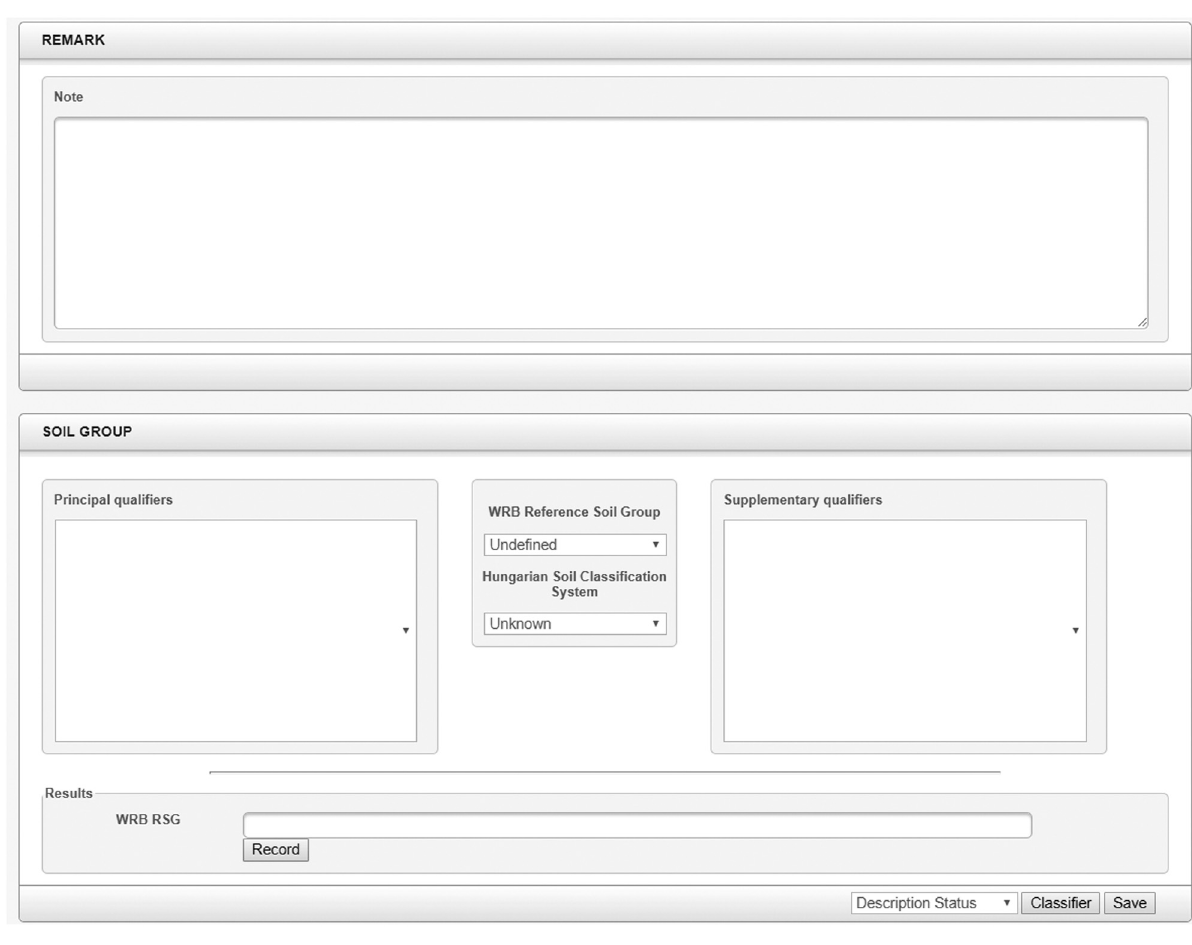
Figure 15: Interface for remark and soil classi fi cation.